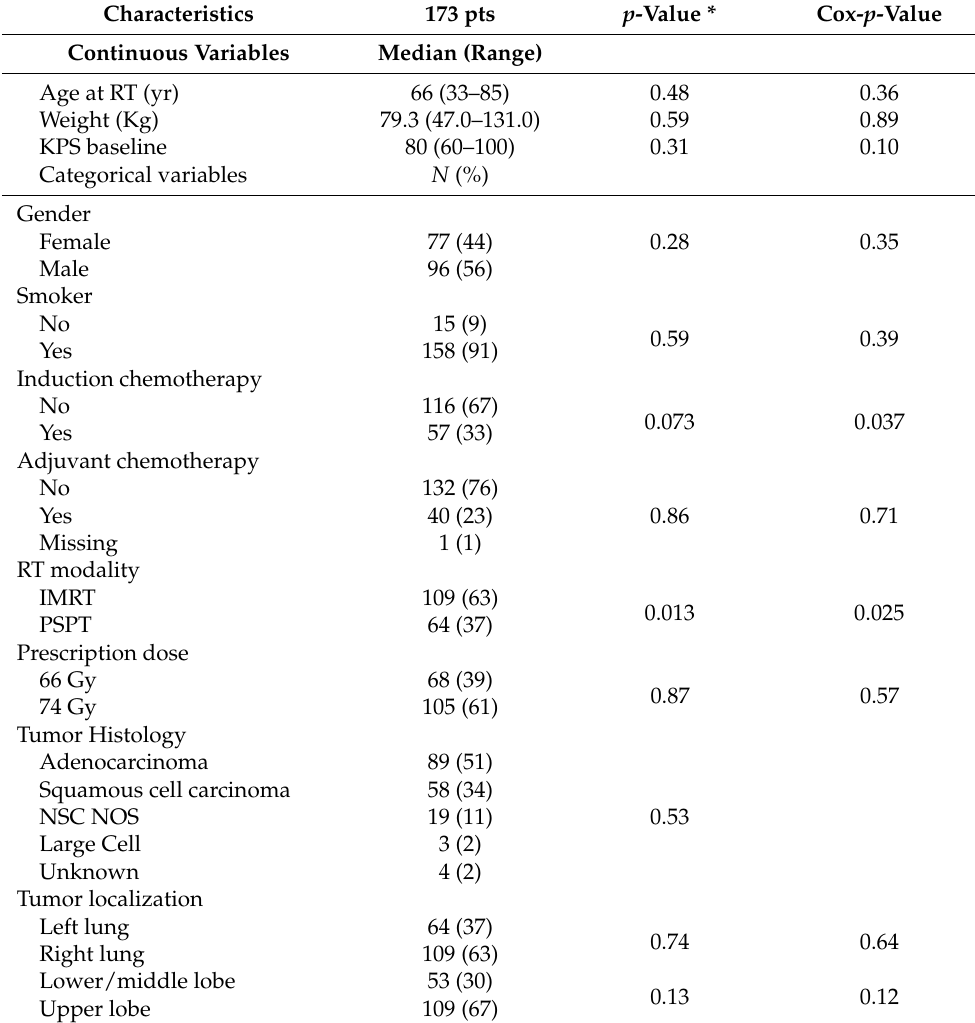
Table 1. Patient and treatment characteristics and univariate analyses for radiation-induced esophagitis